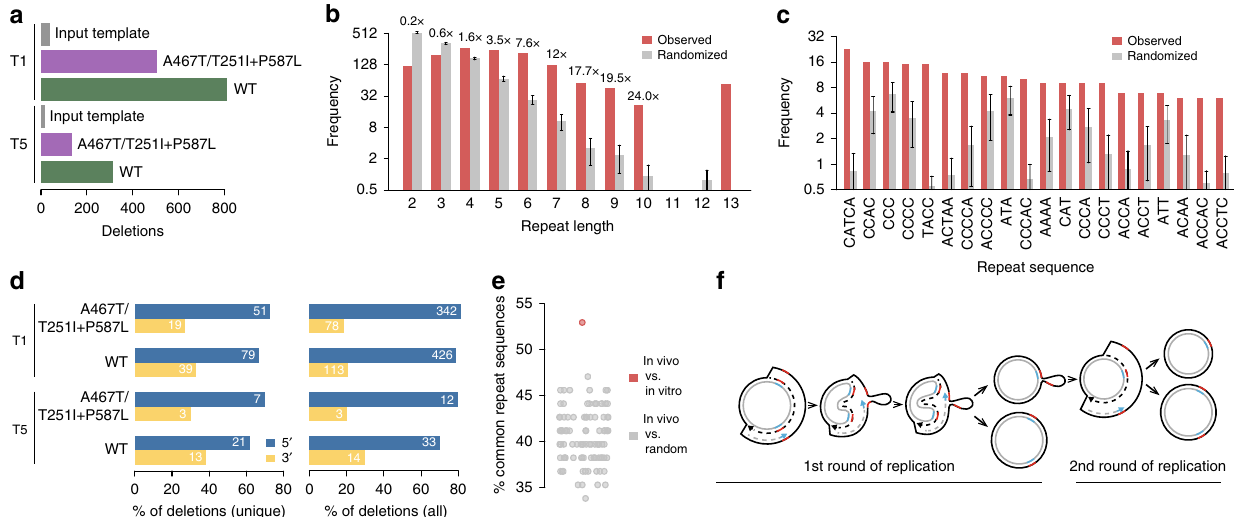
Fig. 5 Similar mtDNA deletions formed in vitro and in vivo. a Frequency of deletions detected in mtDNA inserts (nt 8187 – 87784, 13,066 – 13,737) in T1 (barrier) and T5 (wild-type) templates replicated in vitro by indicated POL γ version. Non-replicated templates are included as controls (input template). b Frequencies of exact direct repeats overlapping or fl anking each pair of breakpoints located within the mtDNA sequence in the templates, considering the longest match for each deletion (red bars). Results from randomized breakpoints are shown for comparison (grey bars), with error bars indicating the standard deviation (100 randomizations). c Frequencies for the most commonly observed repeat patterns in vitro using the breakpoints in T1 and T5 from reactions with POL γ wild-type or A467T/T251I + P587L. d Analysis of 5 ′ vs. 3 ′ retention of imperfect repeats, similar to Fig. 1e, for deletions formed in vitro. Results are shown for unique deletions as well as the complete set of deletions. e Non-random overlap between repeat sequences detected in vivo and in vitro. The fraction overlapping repeat patterns (minimum length 3 bp) in the in vitro and the in vivo data was determined (red), considering both templates and only breakpoints in the region common to both datasets. Results from 100 sets of randomly generated deletions are shown as controls (grey; P = 0.02, two-sided Wilcoxon test). f Schematic model of copy-choice recombination. The parental H-strand is represented in solid black with the repeats as red blocks. The parental L-strand is represented in solid grey with the repeats as blue blocks. The newly synthesized strands are in dashed lines. During SDM, replication repeats in the parental H-strand are exposed in their single-stranded conformation. Secondary structures in DNA may bring the repeats close to each other. If the replication machinery dissociates during replication of the fi rst repeat, the 3 ′ -end of the newly synthesised DNA can unpair from the fi rst repeat and mispair with the second repeat. When DNA synthesis is restarted, a heteroduplex molecule is formed and the repeat closest to OriH will be lost together with intervening sequence. A deletion-containing double-stranded molecule is formed following a second round